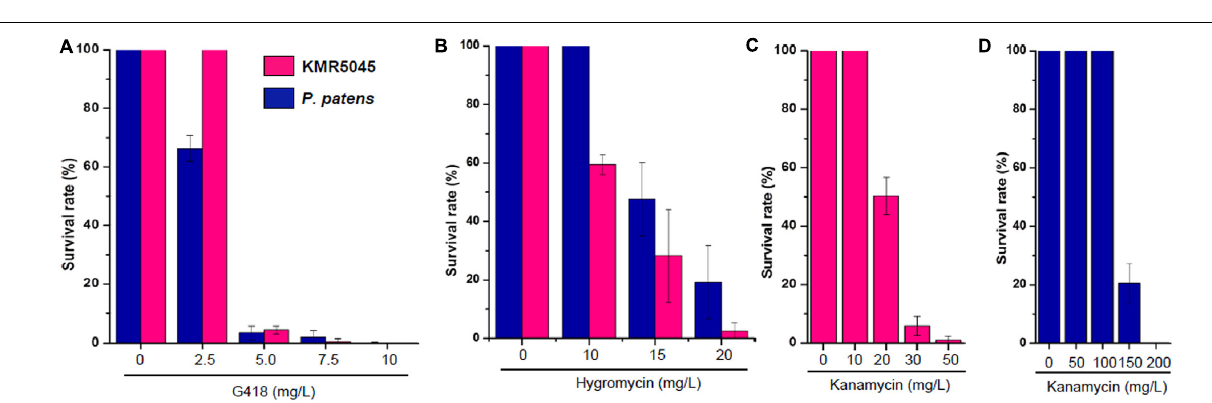
FIGURE 6 | Survival rates of regenerated KMR545 and P. patens protoplasts on Knop medium containing various concentrations of antibiotics. (A) G418. (B) Hygromycin. (C,D)